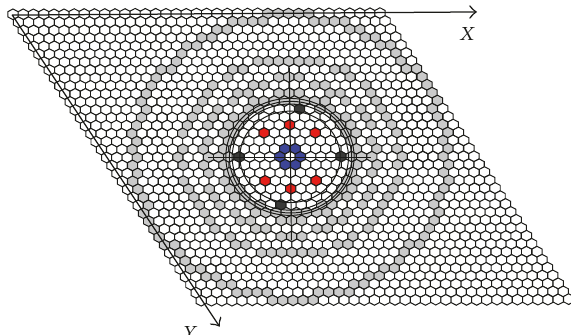
Figure 4: Full-core model with hexagonal